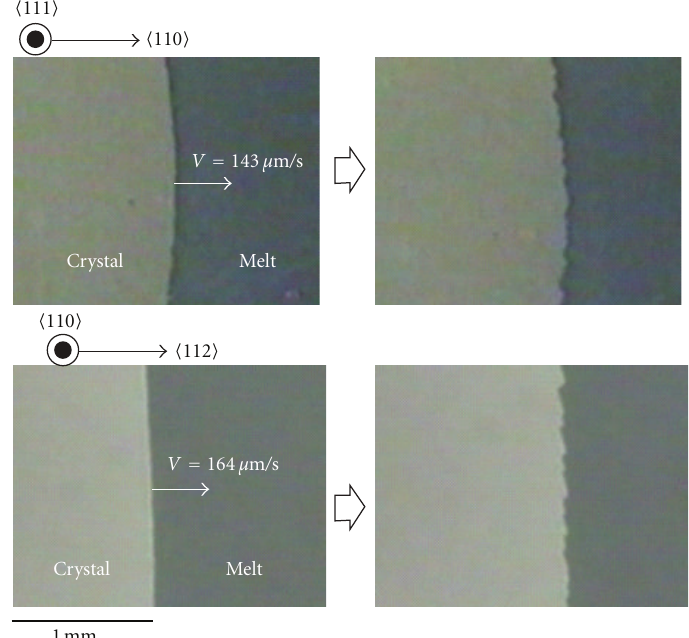
Figure 2: Morphological transformation of Si (110) and (112) crystal-melt interfaces at high growth velocities [11].